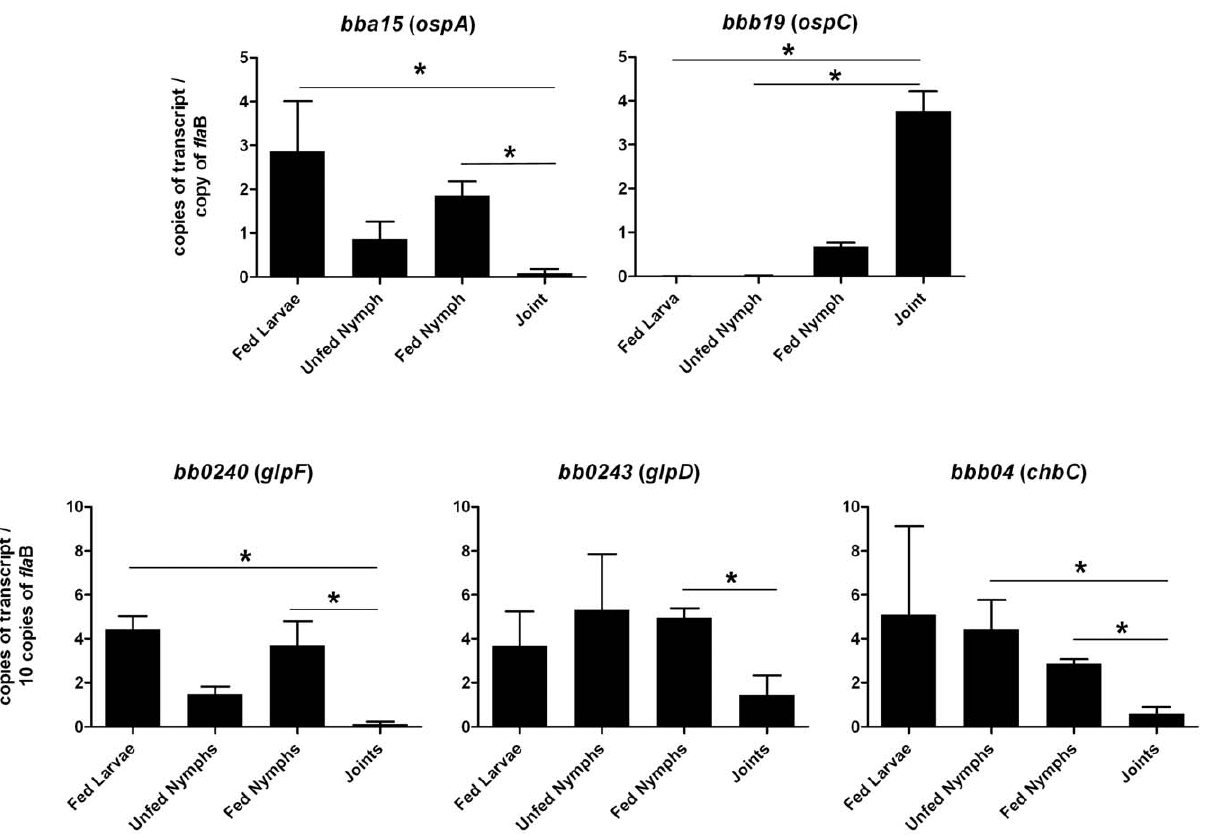
Figure 5. Transcriptional analysis of selected genes at different stages of the enzootic cycle. qRT-PCR was performed with RNA isolated from strain B31-A3-infected ticks and mouse joints as described in Methods. Statistical analysis was determined by Kruskal-Wallis multiple comparison Z- value test; * significant difference ( P # .05) between samples. Error bars indicate standard error of the mean (SEM).